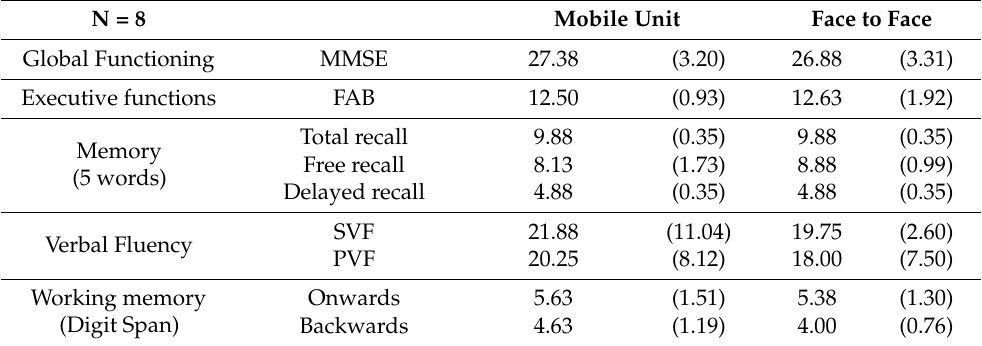
Table 2. Group comparison of the cognitive assessments. Mean (Standard deviation).